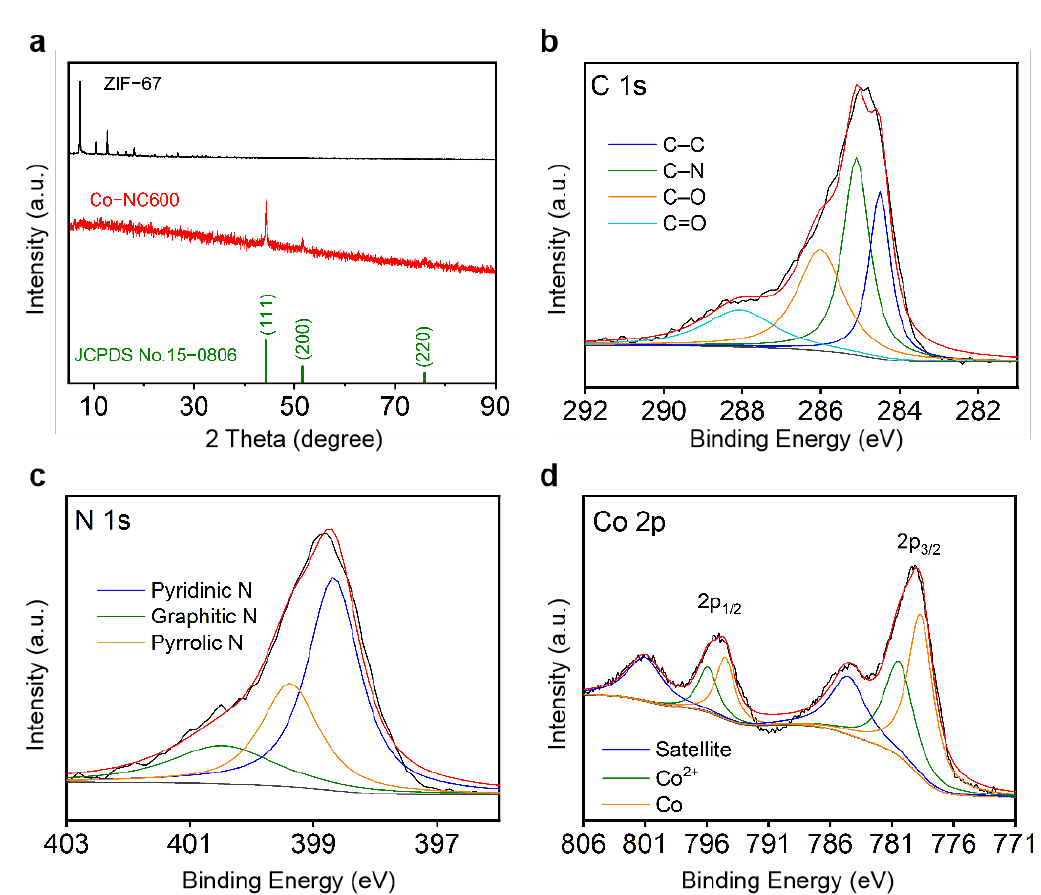
Figure 2. ( a ) XRD pattern of ZIF-67 and Co-NC600; XPS spectra of ( b ) C 1s, ( c ) N 1s and ( d ) Co 2p for Co-NC600.